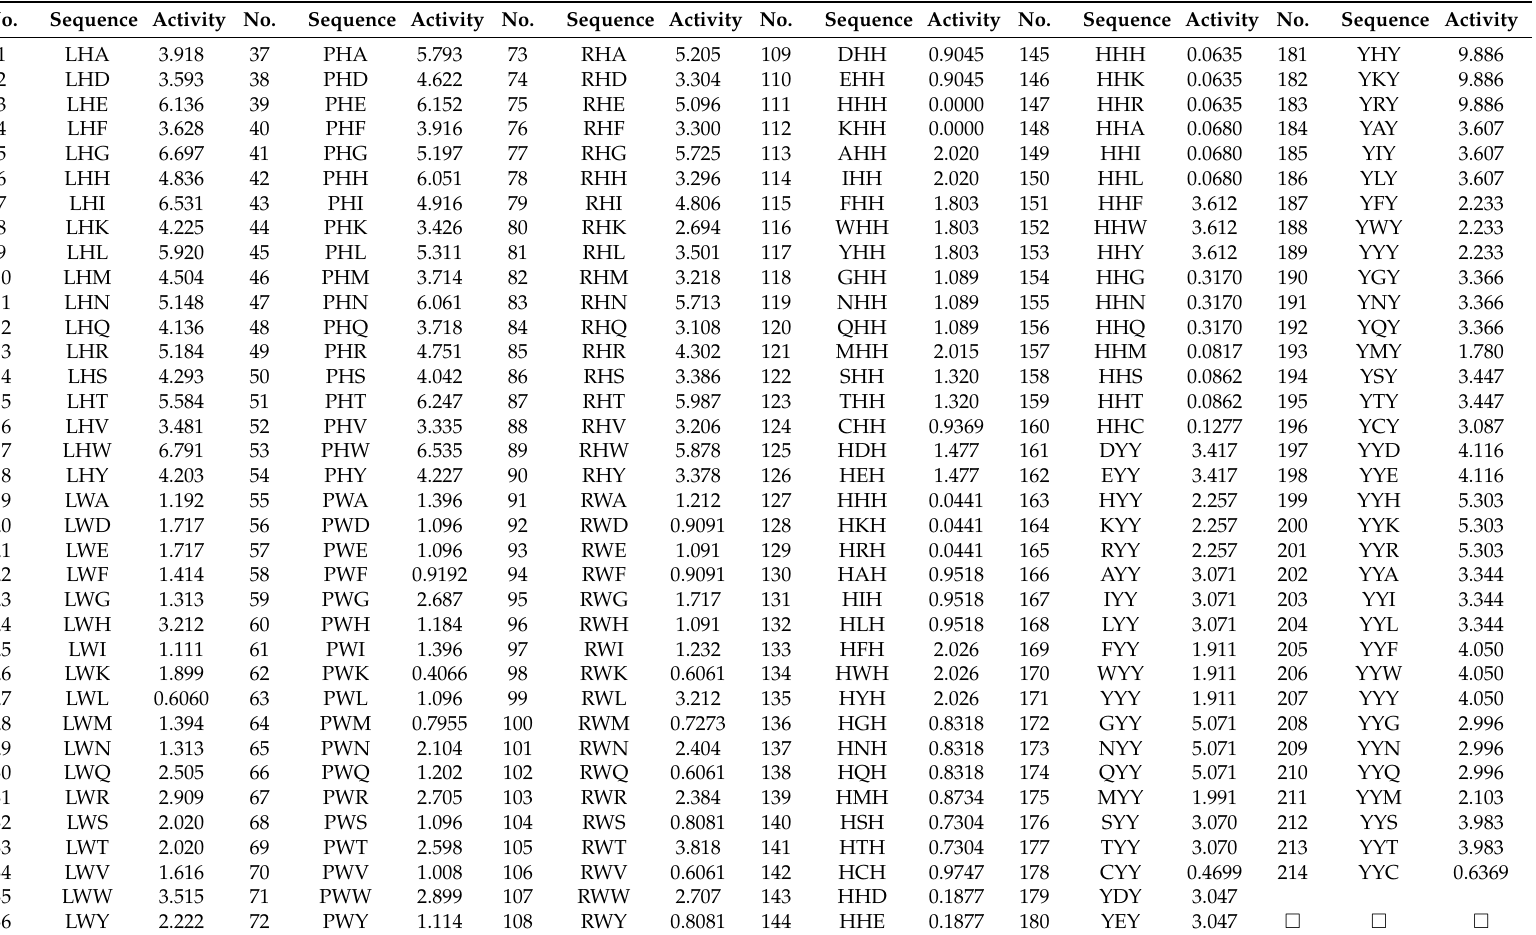
Table 3. Sequences and antioxidant activities of tripeptides on ferric thiocyanate (FTC) dataset a